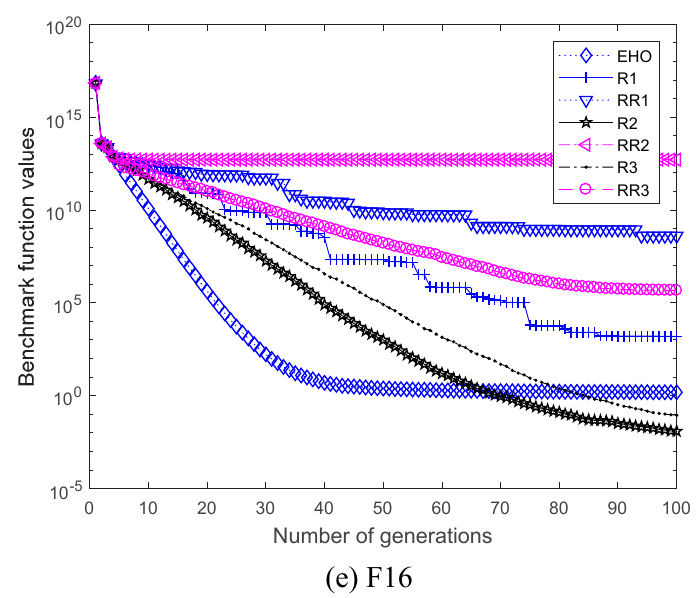
Figure 3. Optimization process of seven algorithms on five functions with D = 200.